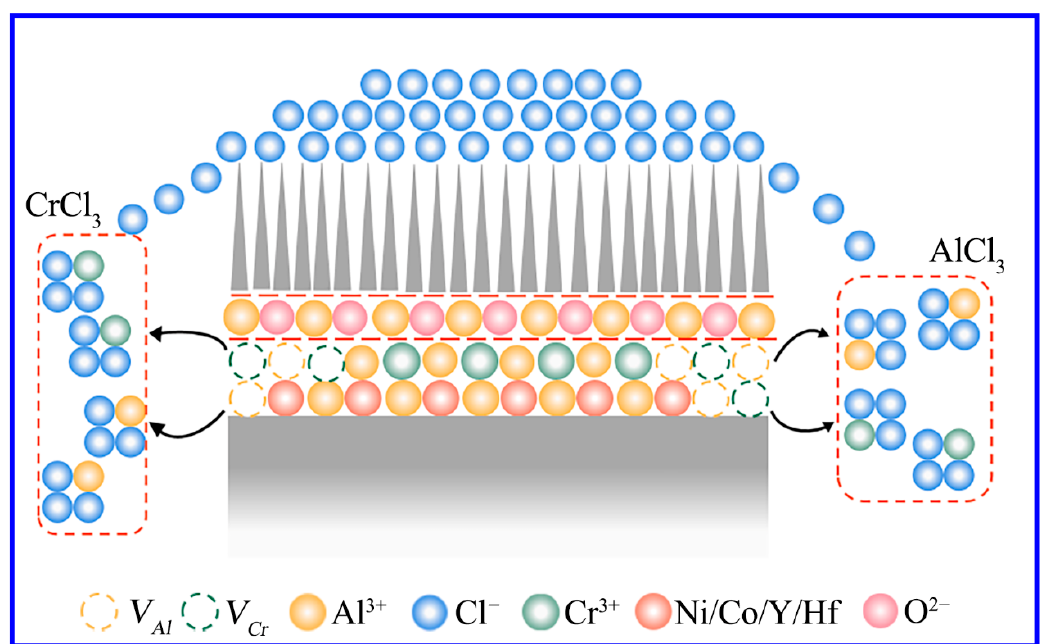
Figure 15. The degradation process of the bond coating exacerbated by